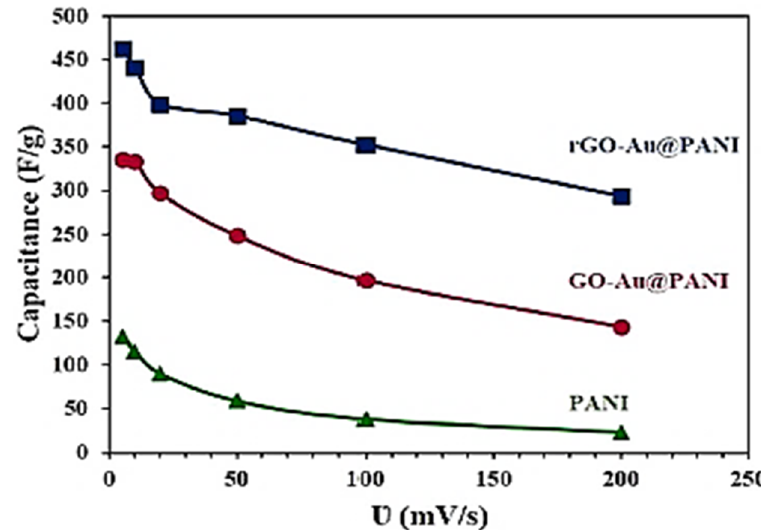
Figure 6. Dependence of specific capacitance on the scan rate (5–200 mVs −1 ) for pristine PANI, GO- Au@PANI, and rGO-Au@PANI [118]. PANI = polyaniline; GO-Au@PANI = graphene oxide-gold nanoparticle@polyaniline; rGO-Au@PANI = reduced graphene oxide-gold nanoparticle@polyani- line. Reproduced with permission from Elsevier.